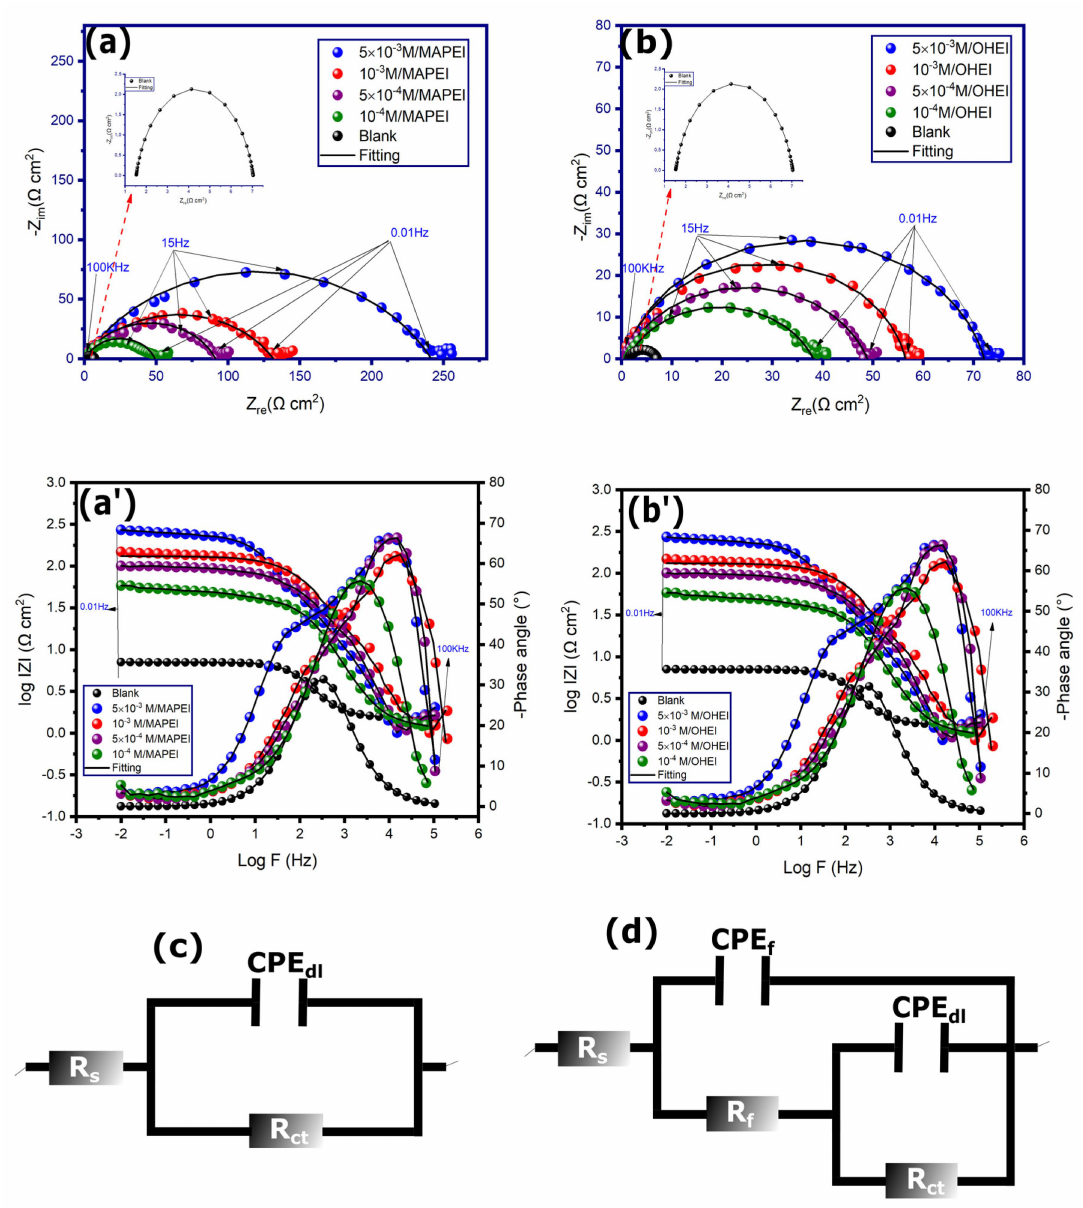
Figure 2. EIS data of N80 steel in 15% HCl with and without different concentrations of inhibitors; ( a , a’ ) Nyquist and Bode plots of MAPEI; ( b , b’ ) Nyquist and Bode plots of OHEI, respectively. ( c , d ) Equivalent electrical circuits used to fit EIS